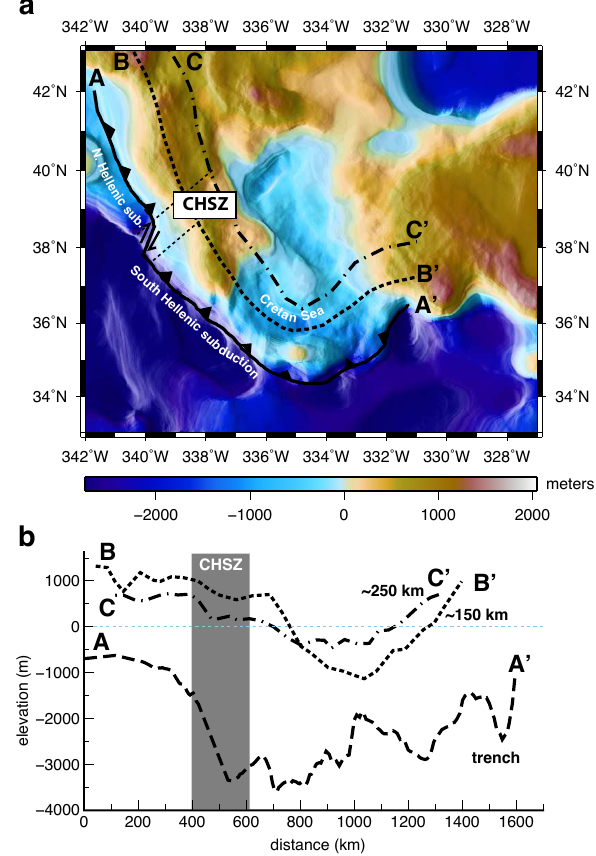
Fig. 11. (a) Smoothed topography of the Aegean region. ETOPO1 global topography (Amante and Eakins, 2009) has been filtered with a 150km large median filter using Generic Mapping Tools (Wes- sel and Smith, 1998). (b) Topographic profiles of the trench (A– A 0 ; dashed line) and of the Aegean overriding lithosphere at a dis- tance of ∼ 150km (B–B 0 ; dotted line) and ∼ 250km (C–C 0 ; dashed- dotted line) from the